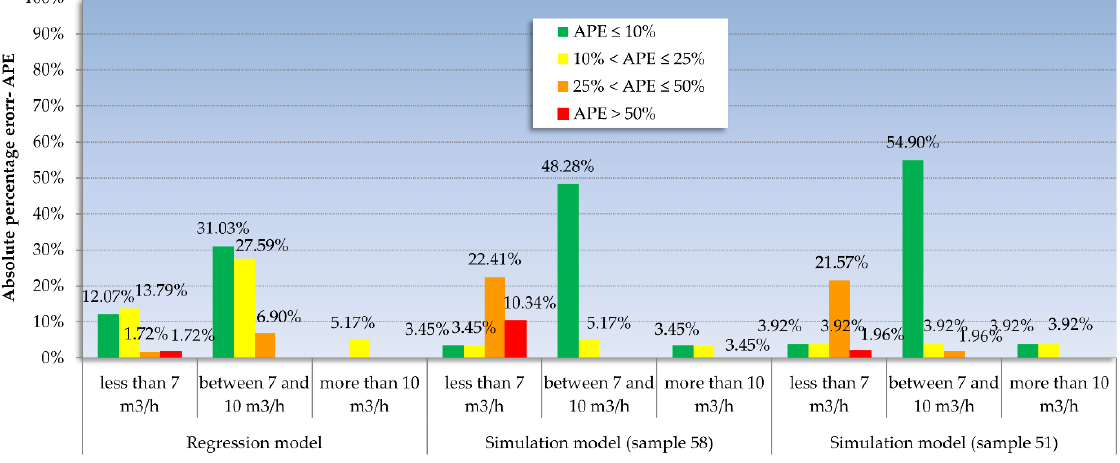
Figure 9. Predicted value errors for the regression and the simulation model, according to productivity groups.